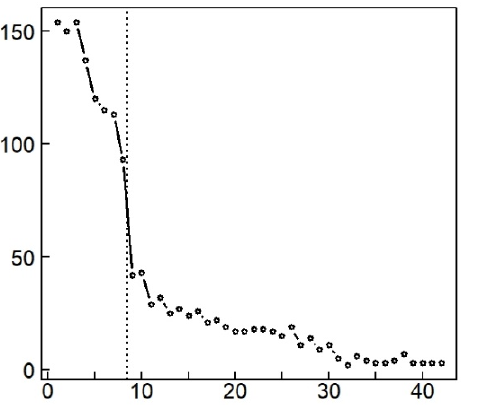
Figure A3. Number of samples ( y -axis) as a function of the number of years since a fire ( x -axis).